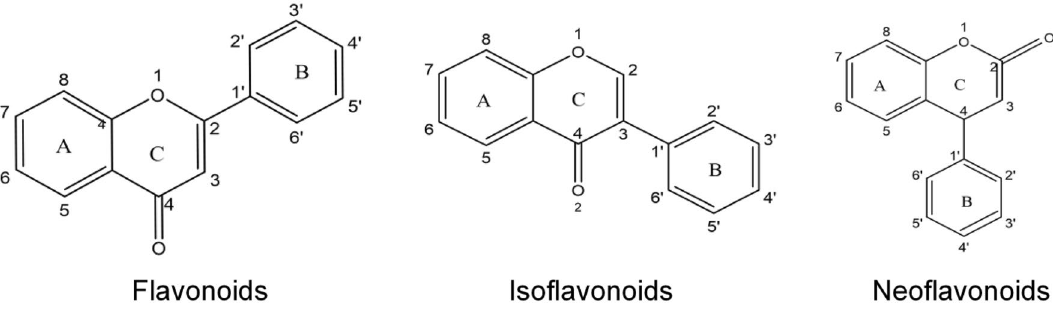
Figure 1. Main parent structures of flavonoids.